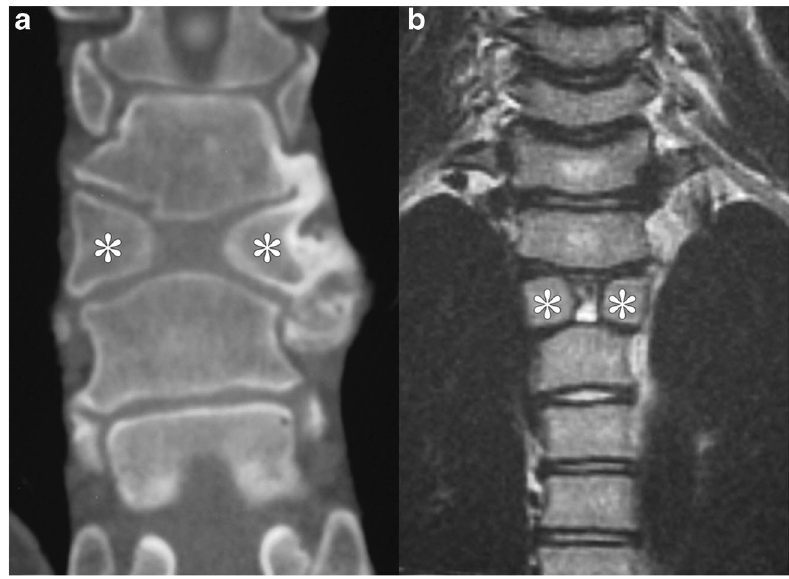
Fig. 12 Butterfly vertebra in two patients: Coronal reformatted image from a non-contrast CT of the spine ( a ) and coronal T1- weighted MR image of the upper thoracic spine ( b ) both demon- strate separate ossification centres on each side of the vertebral body (marked by asterisks ). Note that there is moulding of the adjacent vertebral bodies towards the mid- sagittal constriction, especially pronounced on